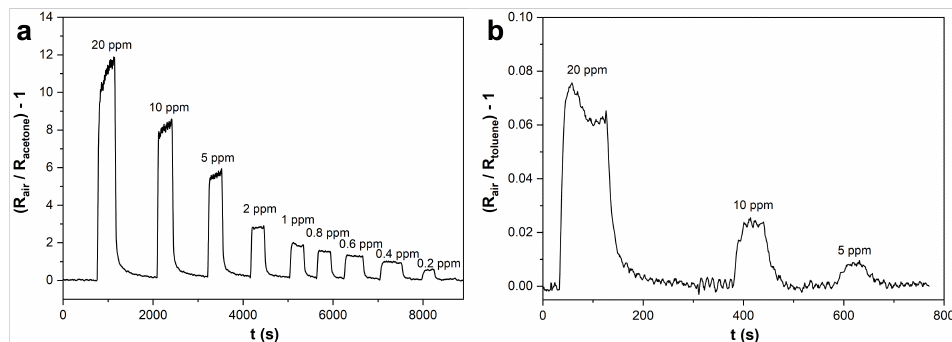
Figure 5. Sensor responses towards decreasing concentrations of ( a ) acetone (20 ppm–200 ppb) and ( b ) toluene (20–5 ppm) gaseous molecules. Tests were performed at 300 ◦ C, in simulated air (80% N 2 –20% O 2